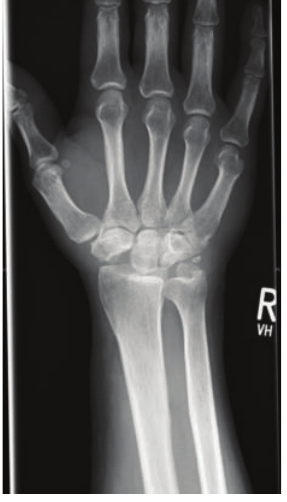
Figure 4: X-ray: postproximal row